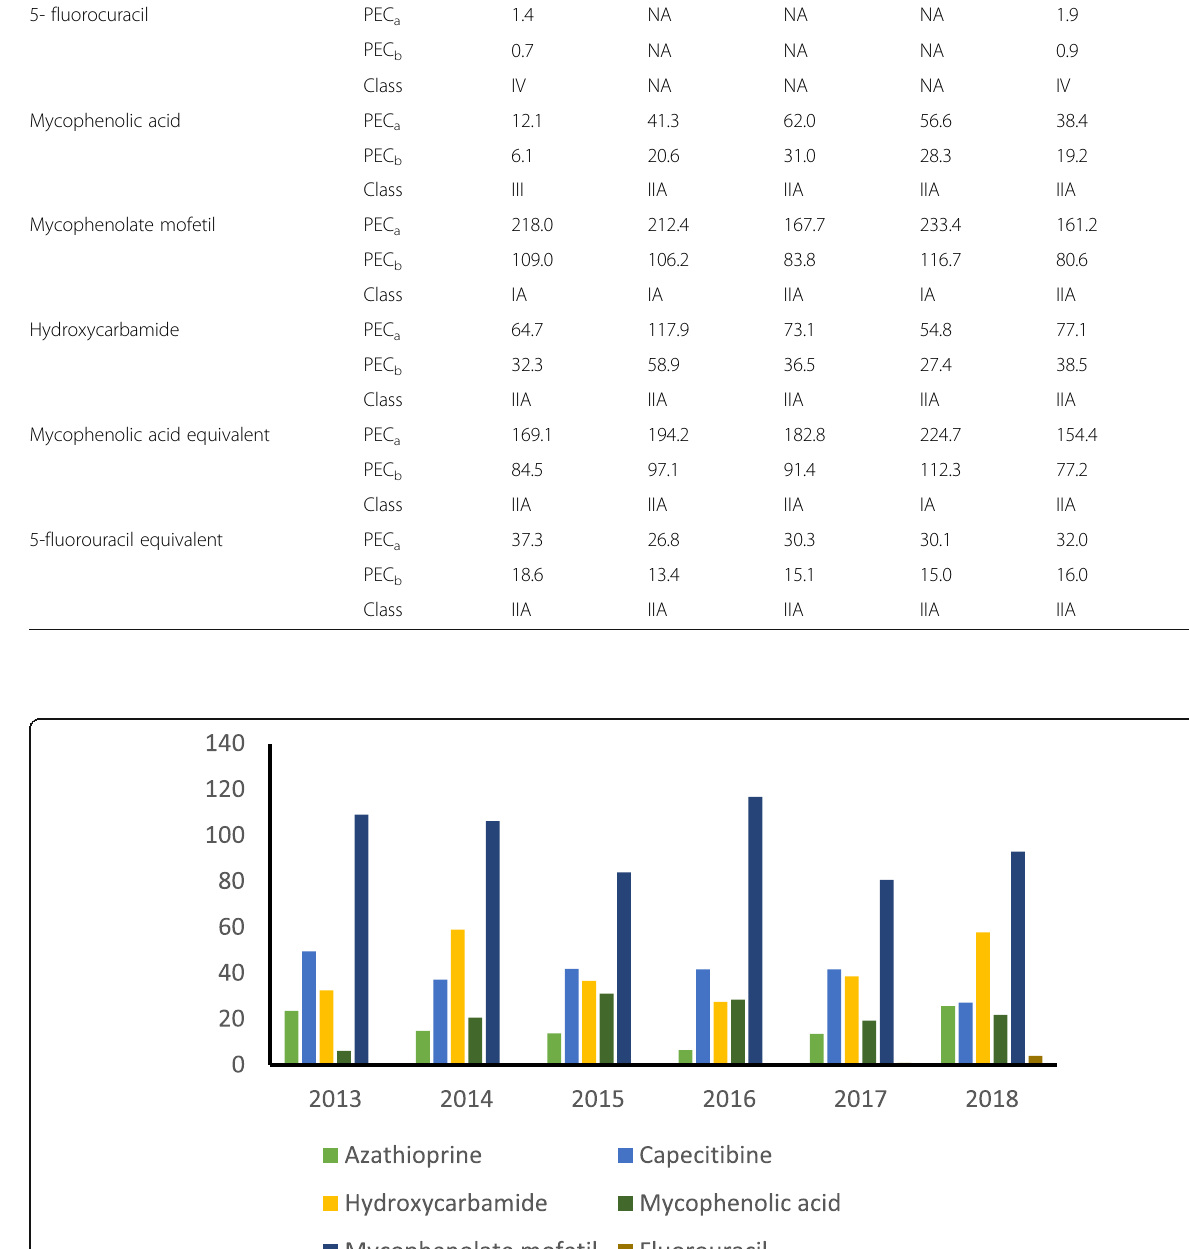
Mycophenolate mofetil